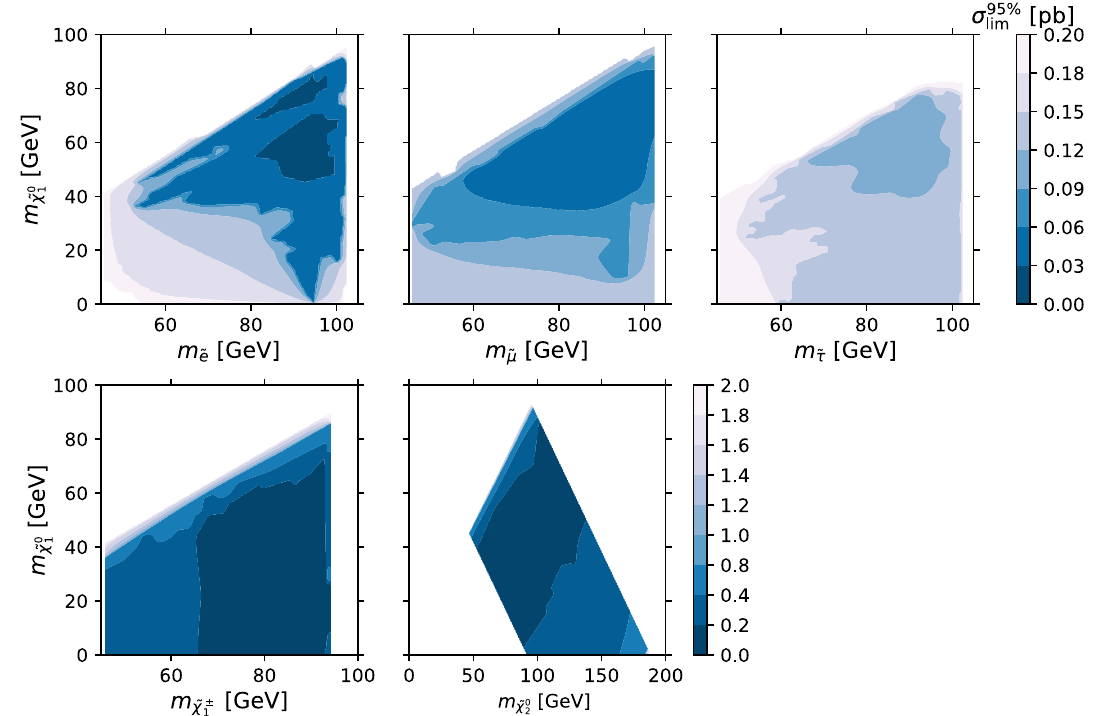
Fig. 7 Interpolated 95% CL on the cross section for pair production of selectrons (upper left), smuons (upper centre), staus (upper right), charginos (lower left) and the next-to-lightest neutralino (lower right),